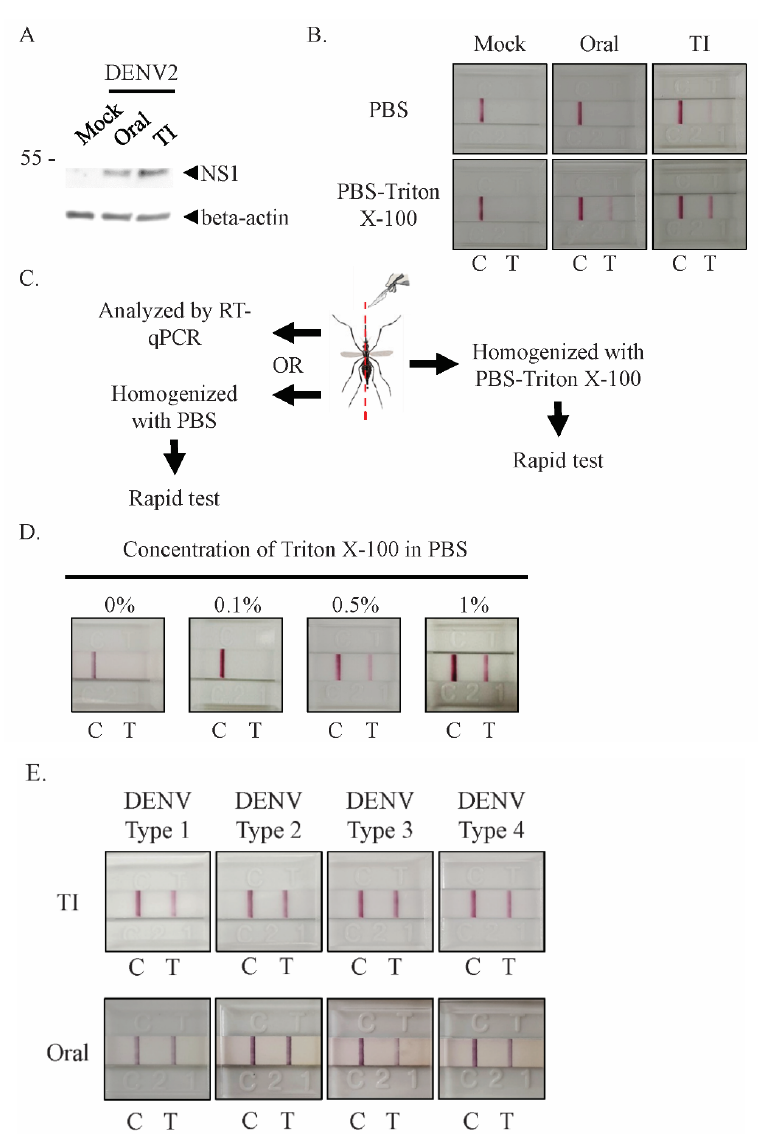
Figure 2. NS1 can be detected in lysate from mosquito bodies when Triton X-100-PBS lysis bu ff er is used. ( A ) Mosquitoes were infected with DENV2 orally (oral) or via thorax injection (TI). After seven days of incubation, infected mosquitoes were homogenized with lysis buffer. Soluble lysates were separated with SDS-PAGE and immunoblotting was performed with anti-NS1 and beta-actin antibodies. ( B – E ) Mosquitoes were orally (oral) or intrathoracically infected (TI) with DENV2 and incubated for seven days. ( B ) Incubated mosquitoes were homogenized with PBS or 1% Triton X-100-PBS bu ff er; both lysates were then tested using the NS1 rapid test. ( C ) To confirm the infection status of orally infected mosquitoes, mosquitoes were longitudinally and symmetrically bisected for homogenization in different lysis buffers or for analysis with different methods. ( D ) The Triton X-100-PBS lysis bu ff er dose-dependent assay for orally infected mosquitoes. Half of each infected mosquito was homogenized with 0.1–1% Triton X-100-PBS bu ff er and tested using the NS1 rapid test strip. ( E ) Mosquitoes were infected with one of the four DENV serotypes via thorax injection or oral infection, before being homogenized with 1% Triton X-100-PBS and tested using the rapid test strip. At least 5 individual mosquitoes were tested per sample. The DENV titer from serotype1 to 4 of TI infected mosquito was 2.2 × 10 4 , 4.0 × 10 4 , 2.9 × 10 4 , and 2.3 × 10 4 , respectively. The virus titer from serotype1 to 4 of orally infected mosquito was 8.9 × 10 3 , 1.1 × 10 4 , 6.8 × 10 3 , and 8.0 × 10 3 , respectively. All control (C) and positive (T) signals were observed within 20